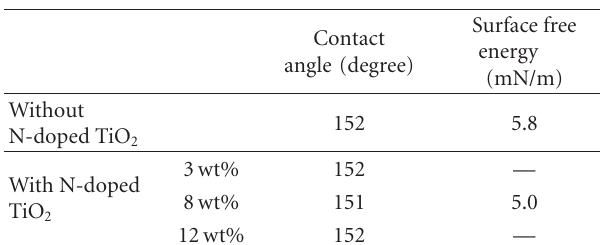
Table 1: Contact angles of water and surface free energy on the PTFE hydrophobic composite films with the addition of N-doped TiO 2